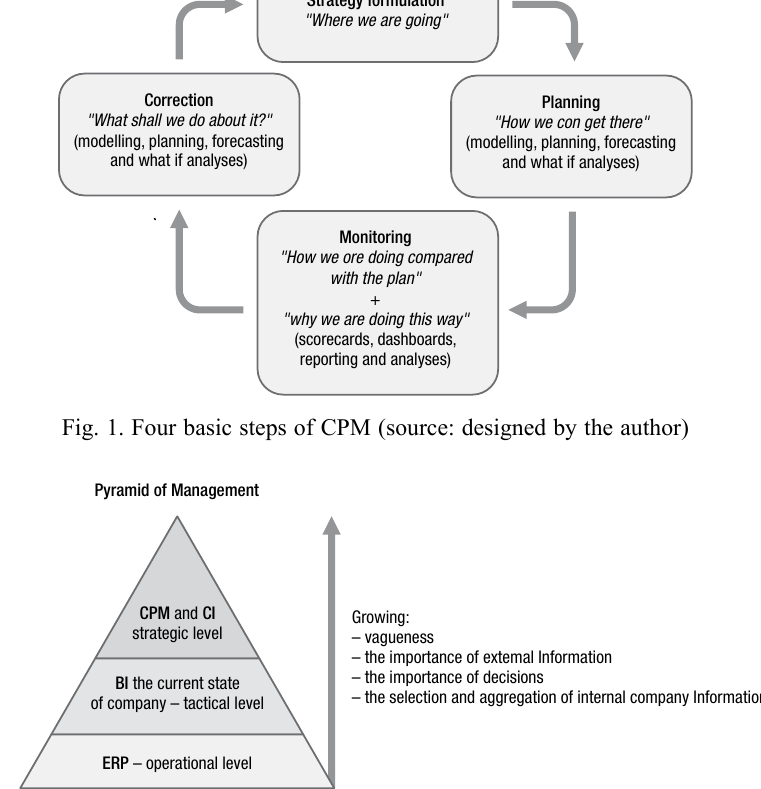
Fig. 2. The position of CPM and CI in the management of companies and institutions